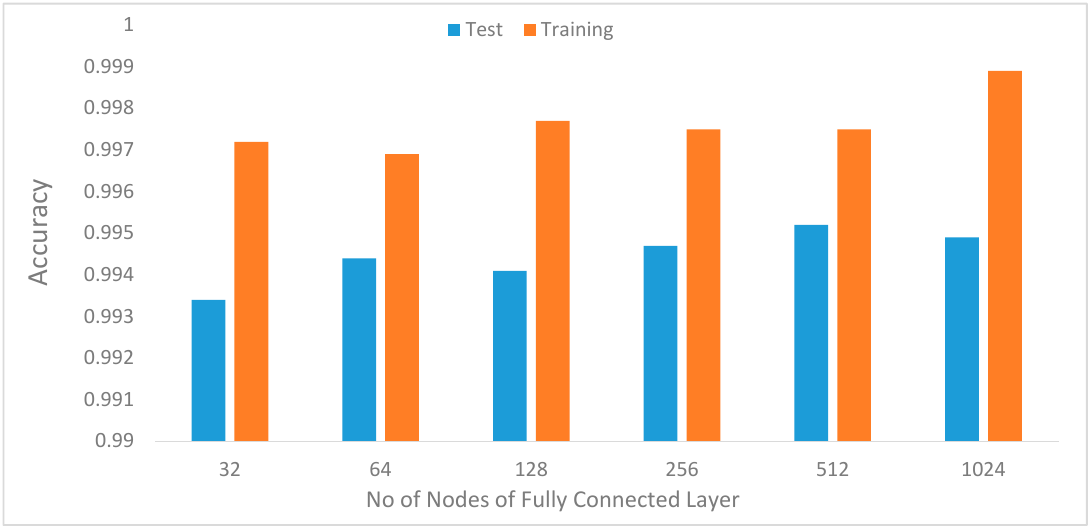
Figure 21. Model recognition accuracy with increasing number of nodes in the fully connected layer.